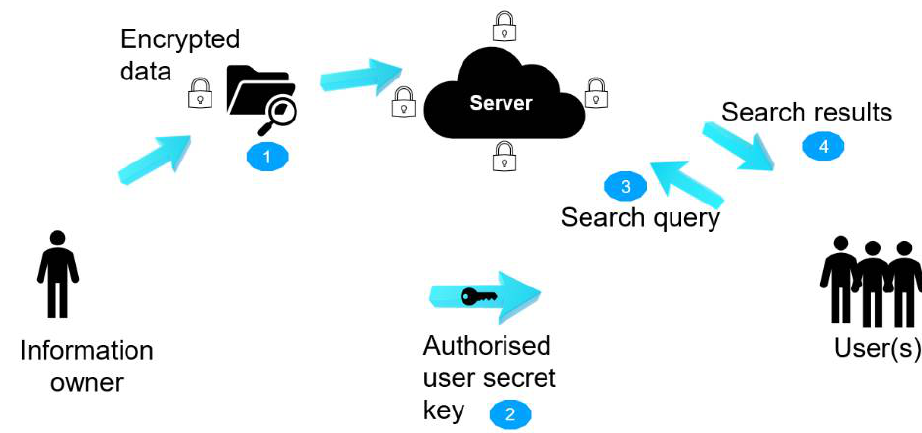
Figure 6. Data sharing with varied stakeholders [51].